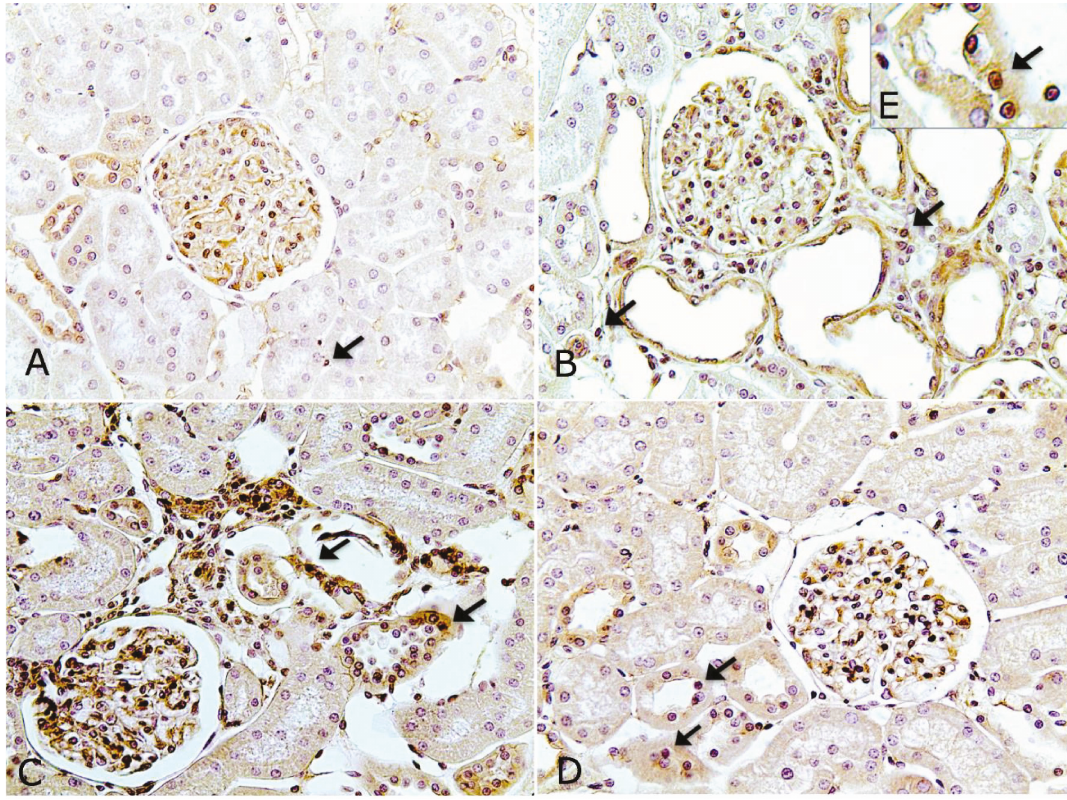
Figure 4: Immunolocalization of NF- κ B (p65) in the renal cortex of SC (a), SD (b), TD (c), and PTD (d) rats. Note the nuclear immunostaining of NF- κ B in (e), suggesting the migration of this factor to the nucleus. Note also lesser intensity of NF- κ B immunostaining in PTD. Original magni fi cation ×